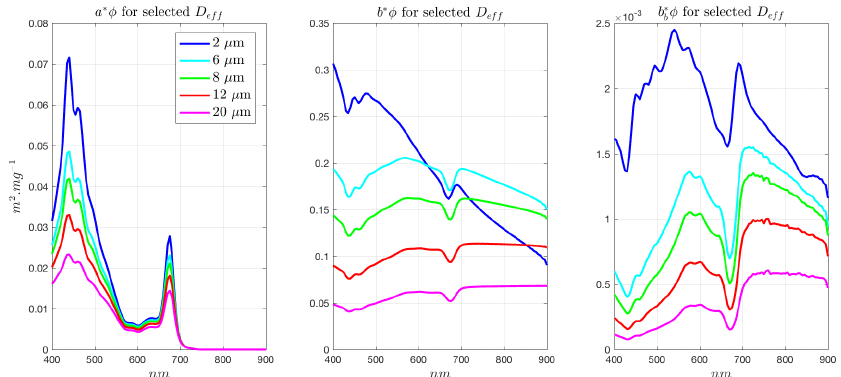
Figure A2. EAP Eukaryote Chl a -carotenoid-dominated IOPs for a range of assemblage D ef f .